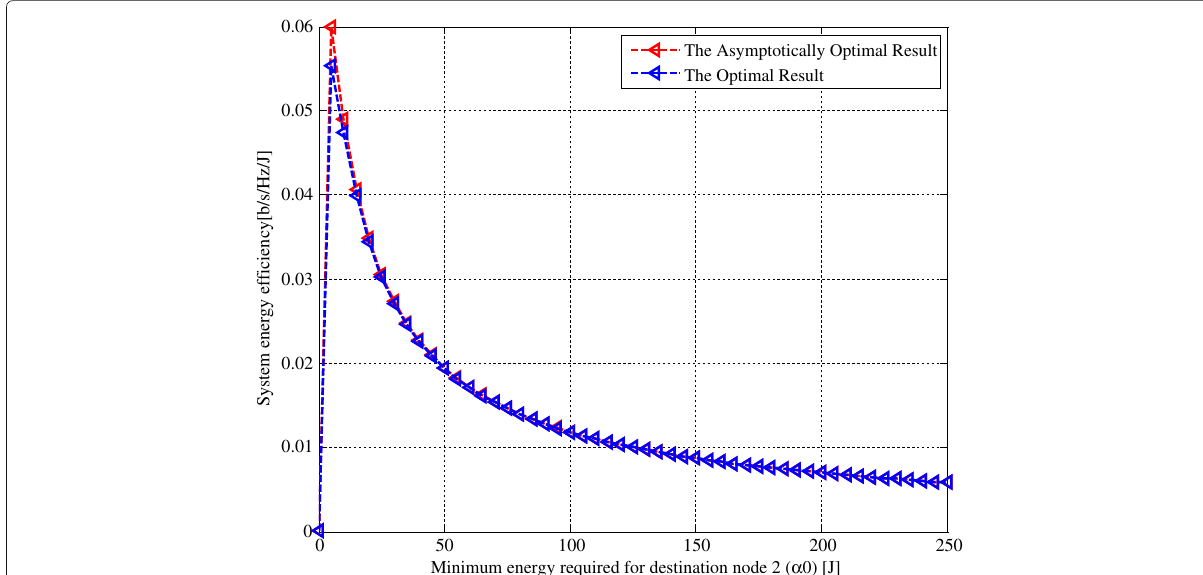
Fig. 6 The comparison between the asymptotically optimal result and the globally optimal